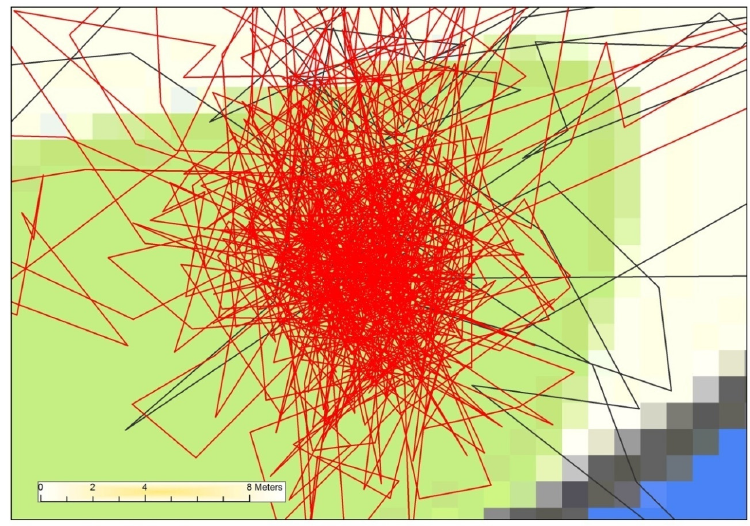
Figure 18. Map showing GPS tracks of island field visit, 22–23 August 2013 (1:100) (Base map data: © Crown Copyright and Database Right [2013], Ordnance Survey (Digimap